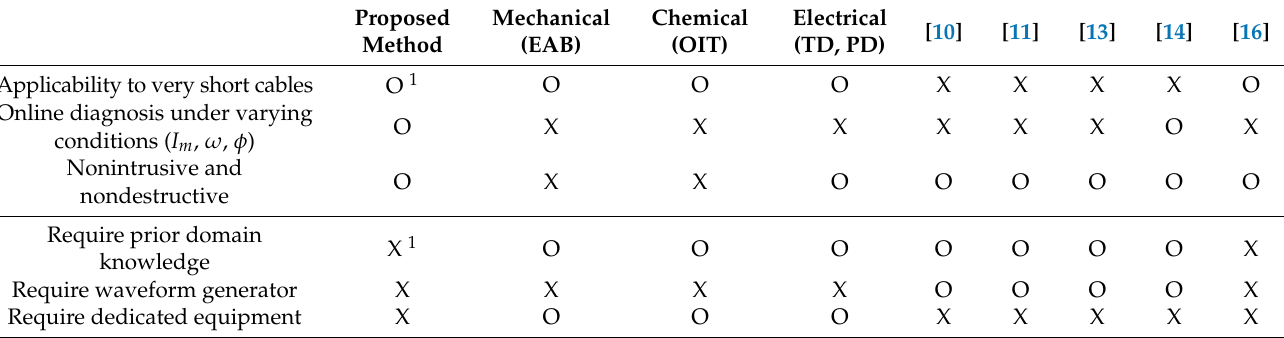
Table 6. Comparison with other